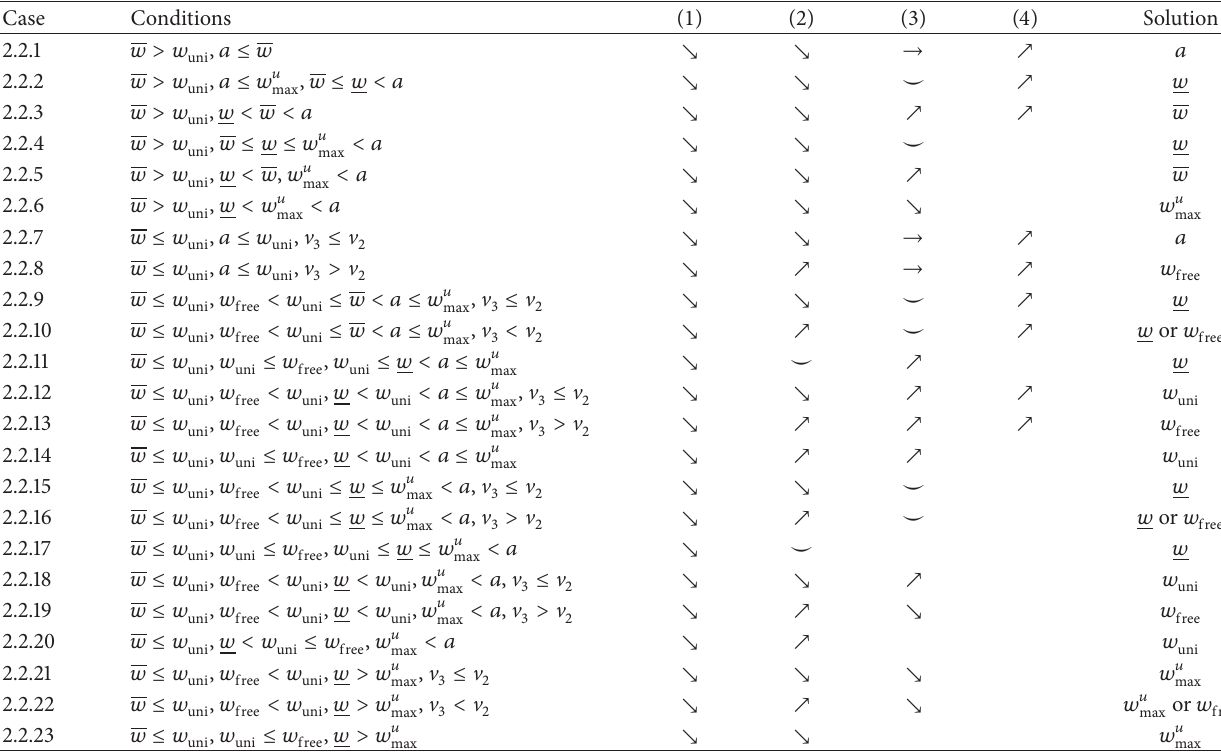
Table 8: Case 2.2 .